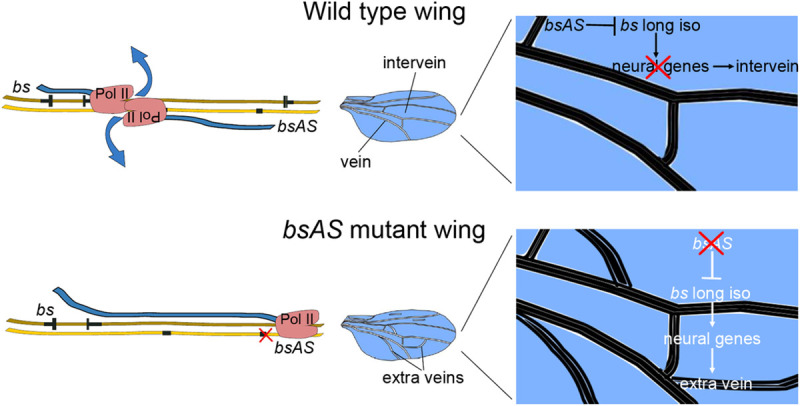
Regulation of bs isoform by bsAS.In the upper and bottom panels, positive and negative DNA strands are depicted as dark and light brown ribbons, respectively. Transcribed exons are depicted in black, narrow bars represent non-coding regions and wide bars represent coding regions. Blue ribbons represent nascent RNA. Upper panel. In wild type tissues, the transcription of bsAS inhibits the expression of bs long isoforms in the intervein regions, likely due to the collision of the RNA Polymerases elongating along both strands, which results in the short isoform being the predominant. Lower panel. In bsAS mutant wing intervein regions, as well as in eye tissues, the RNA Polymerase II is recruited only in the positive strand, allowing for the elongation until the end of the locus, and the long isoforms are fully transcribed. The expression of the bs long isoforms in intervein tissue induces the ectopic expression of neural genes and the appearance of extra veins in these regions.